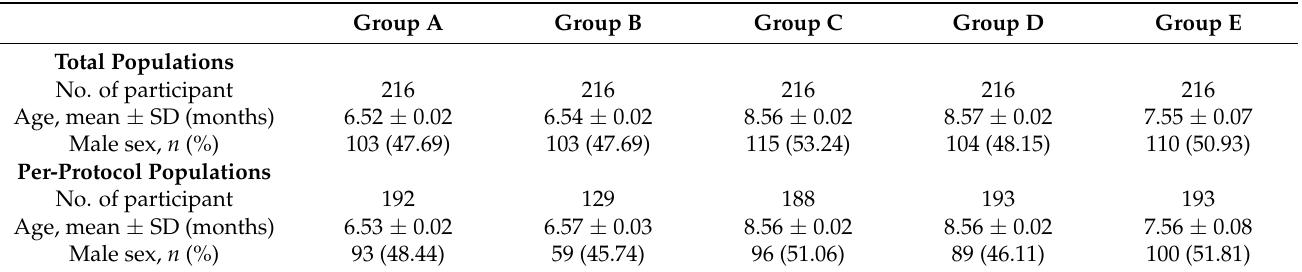
Table 1. Baseline characteristics in total populations and per-protocol